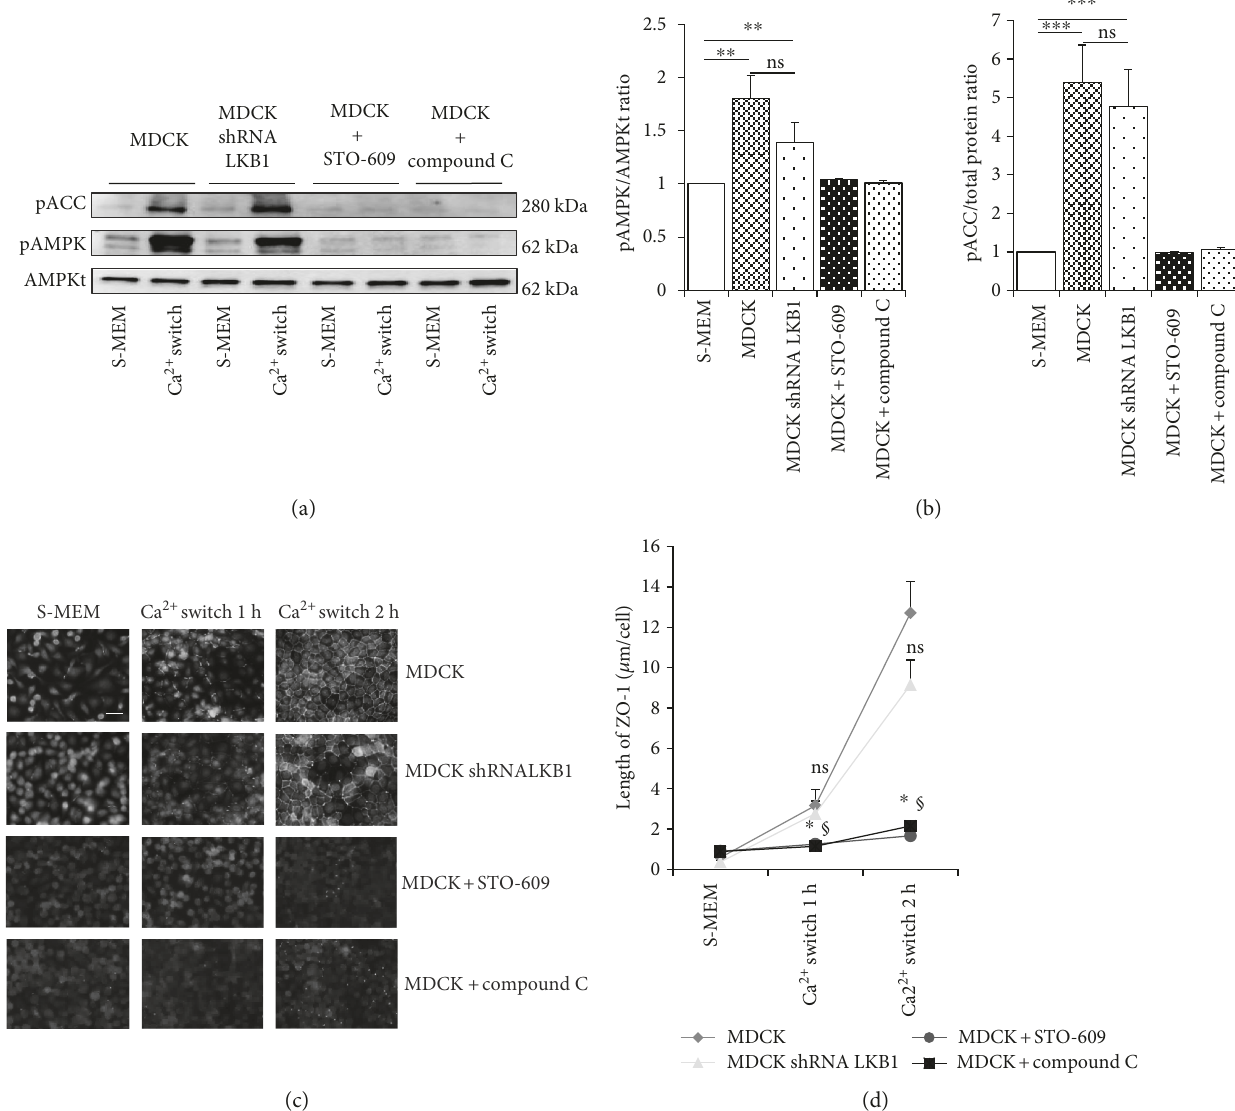
Figure 1: Role of the AMPK kinases, LKB1 and CaMKK, in AMPK activation and ZO-1 relocation following a Ca 2+ switch in MDCK cells. Representative immunoblotting (a) and quanti fi cations (b) of phospho-acetyl-Coa carboxylase (pACC), phospho-AMP-activated protein kinase (pAMPK), and total AMPK (AMPKt) in low Ca 2+ conditions (S-MEM) and following Ca 2+ switch using MDCK cells or LKB1- shRNA MDCK cells. Compounds STO-609 and C were used as CaMKK and AMPK inhibitors, respectively. Quanti fi cations of immunoreactive signals were performed by stain-free method after normalization to total protein content of each lane. Quanti fi cations of phospho-ACC, phospho-AMPK, and AMPKt signals following Ca 2+ switch were calculated and expressed by the ratio to the immunoreactive signal of SMEM condition in each individual experiment (a). For the sake of bar-graph clarity (b), SMEM values of all experiments were normalized to 1 in order to represent mean ratios of phospho-ACC/total protein content and phospho-AMPK/AMPKt in di ff erent experimental conditions (b). Data are presented as mean ± SD; ns: not signi fi cant , ∗∗ p ≤ 0 01 , ∗∗∗ p ≤ 0 001 . Representative immuno fl uorescence (c) and quanti fi cations (d) of ZO-1 deposits at increasing time points following Ca 2+ switch in similar conditions as in (a) and (b) (scale bar: 16 μ m). No statistically signi fi cant di ff erence was observed between MDCK and LKB1-shRNA MDCK (ns: not signi fi cant). MDCK exposed to compound C ( ∗ p ≤ 0 01 ) or STO-609 ( § p ≤ 0 01 ) showed a signi fi cant reduction of ZO-1 relocation in comparison to control MDCK. Data are presented as mean ±